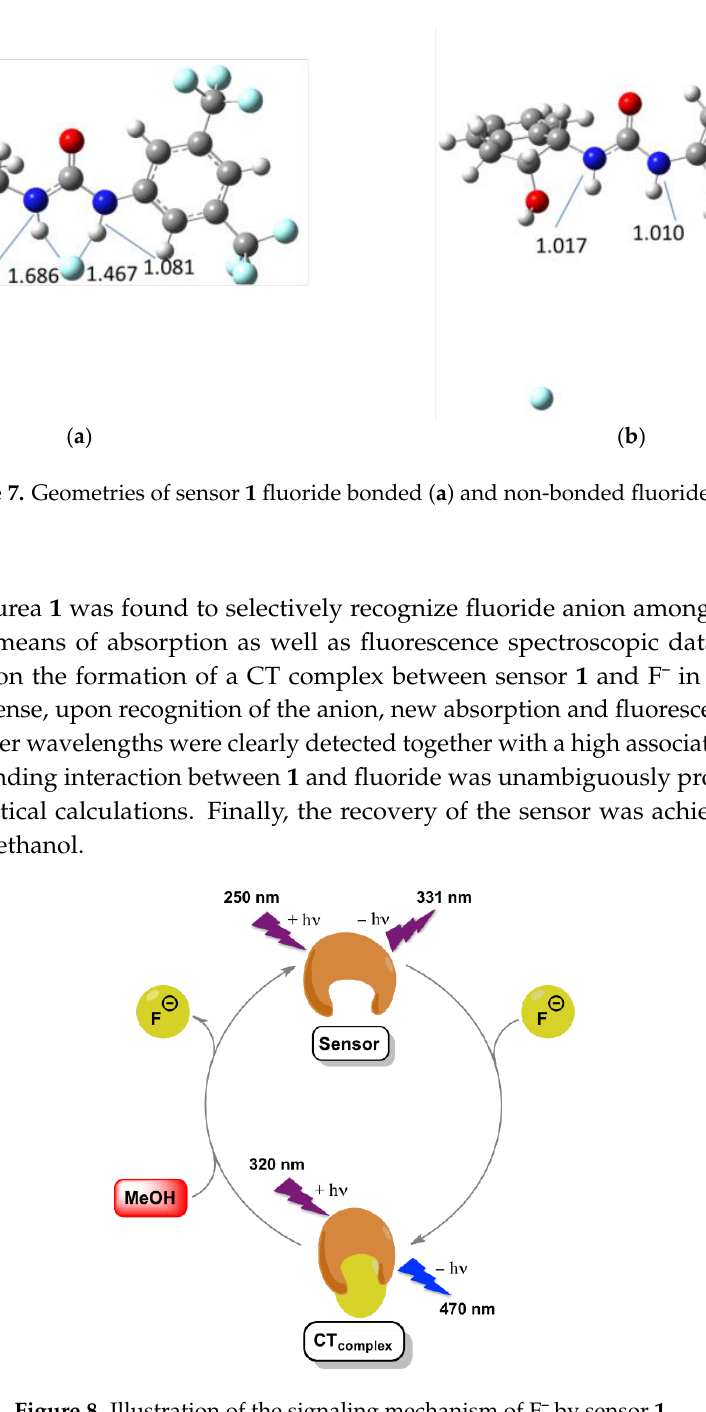
Figure 8. Illustration of the signaling mechanism of F¯ by sensor 1 .